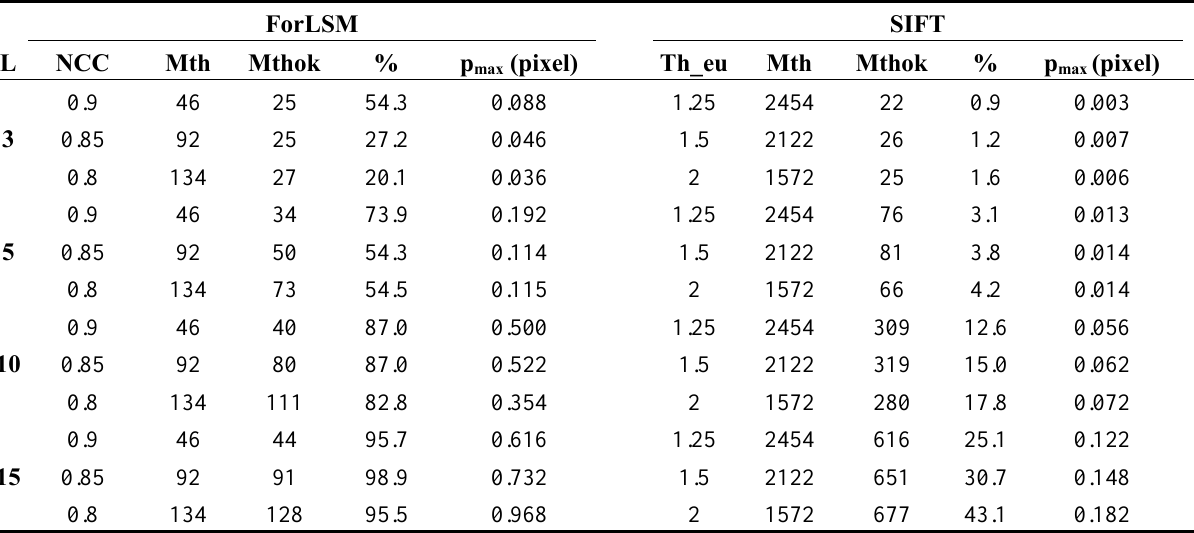
Table 1. The experimental results of the examined operators, in relation to the NCC , Th_eu and L